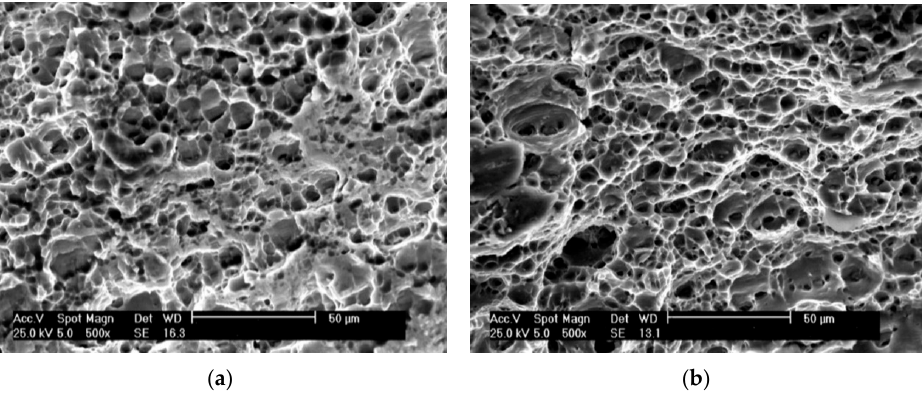
Figure 9. SEM pictures from fracture surfaces of ( a ) FS- and ( b ) FSV-welded specimens.